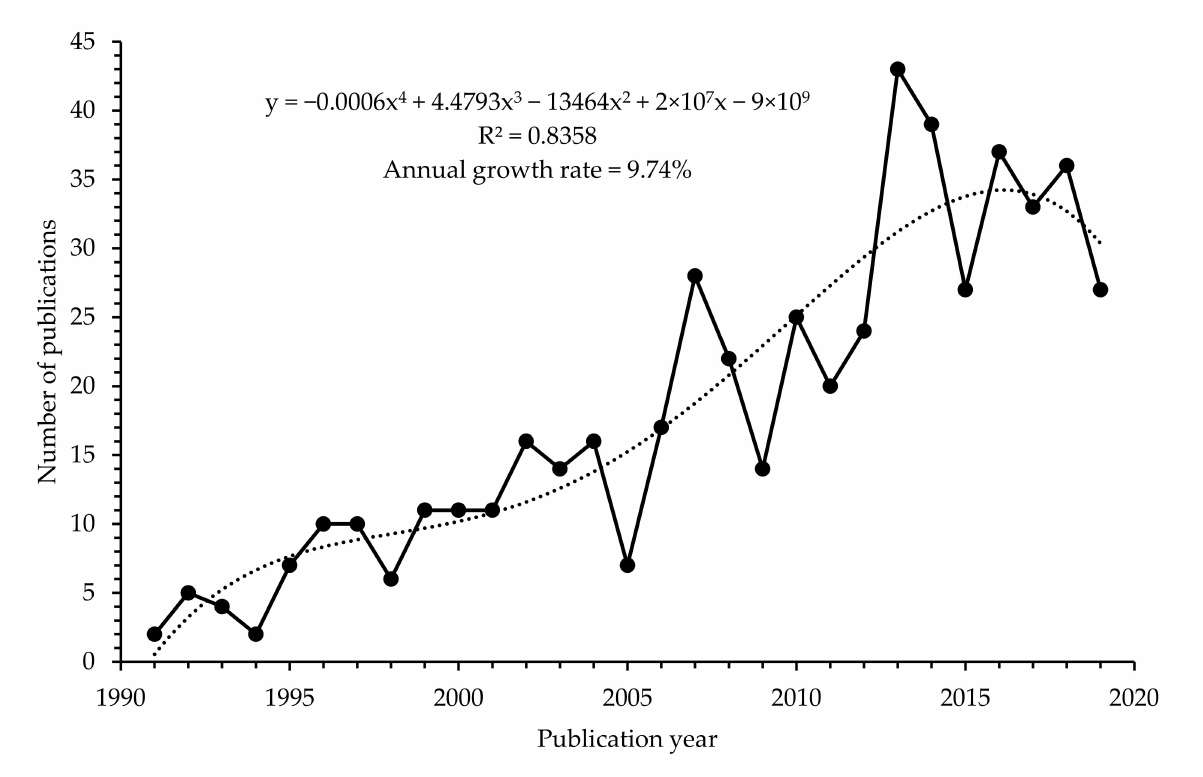
Figure 3. The number of Arcobacter publications from 1991 to